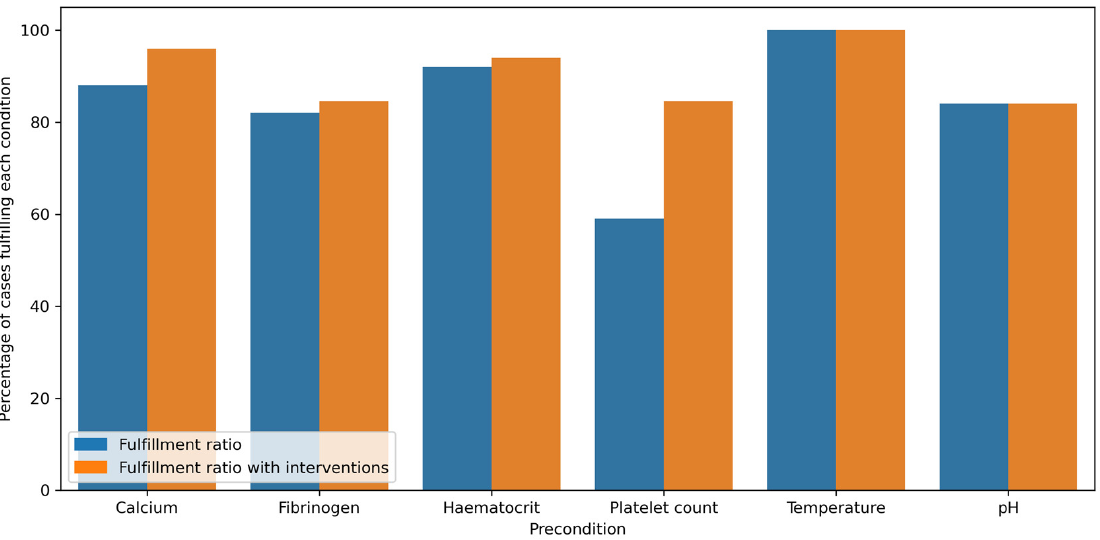
Figure 5. Figure 5. Ful fi llment ratios of the recommended preconditions with and without considering inter- ventions.